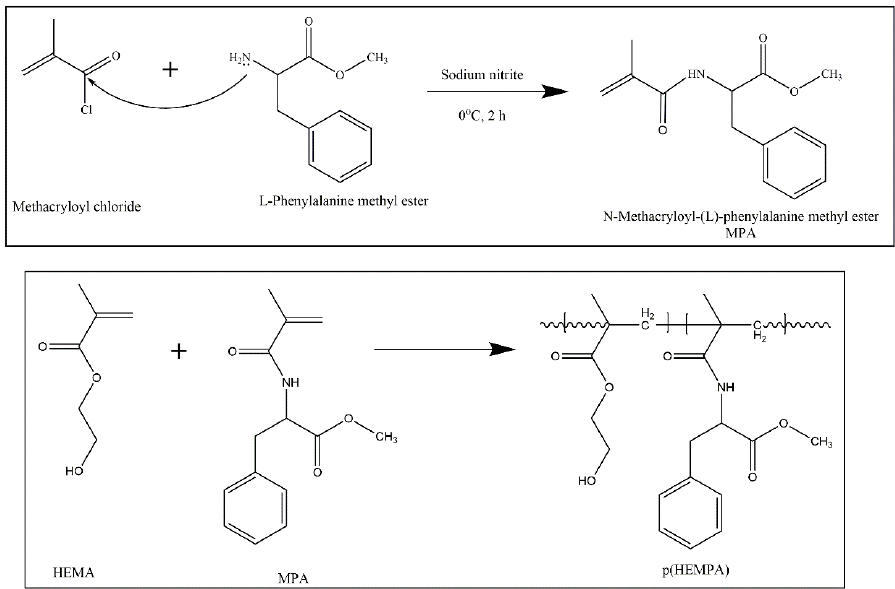
Figure 1. Hypothetical structure of p(HEMPA) nanopolymer synthesized using the mini-emulsion polymerization technique.